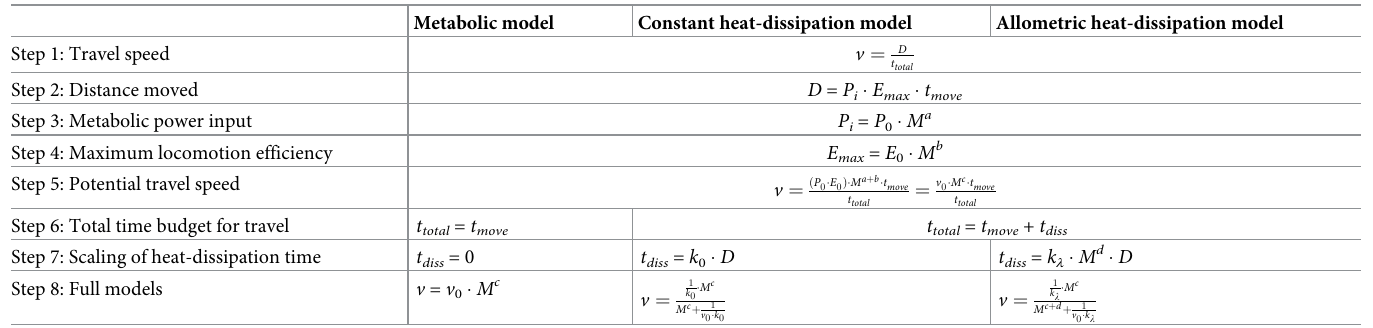
Table 1. Overview of 3 alternative allometric locomotion models and their corresponding mechanistic hypotheses.